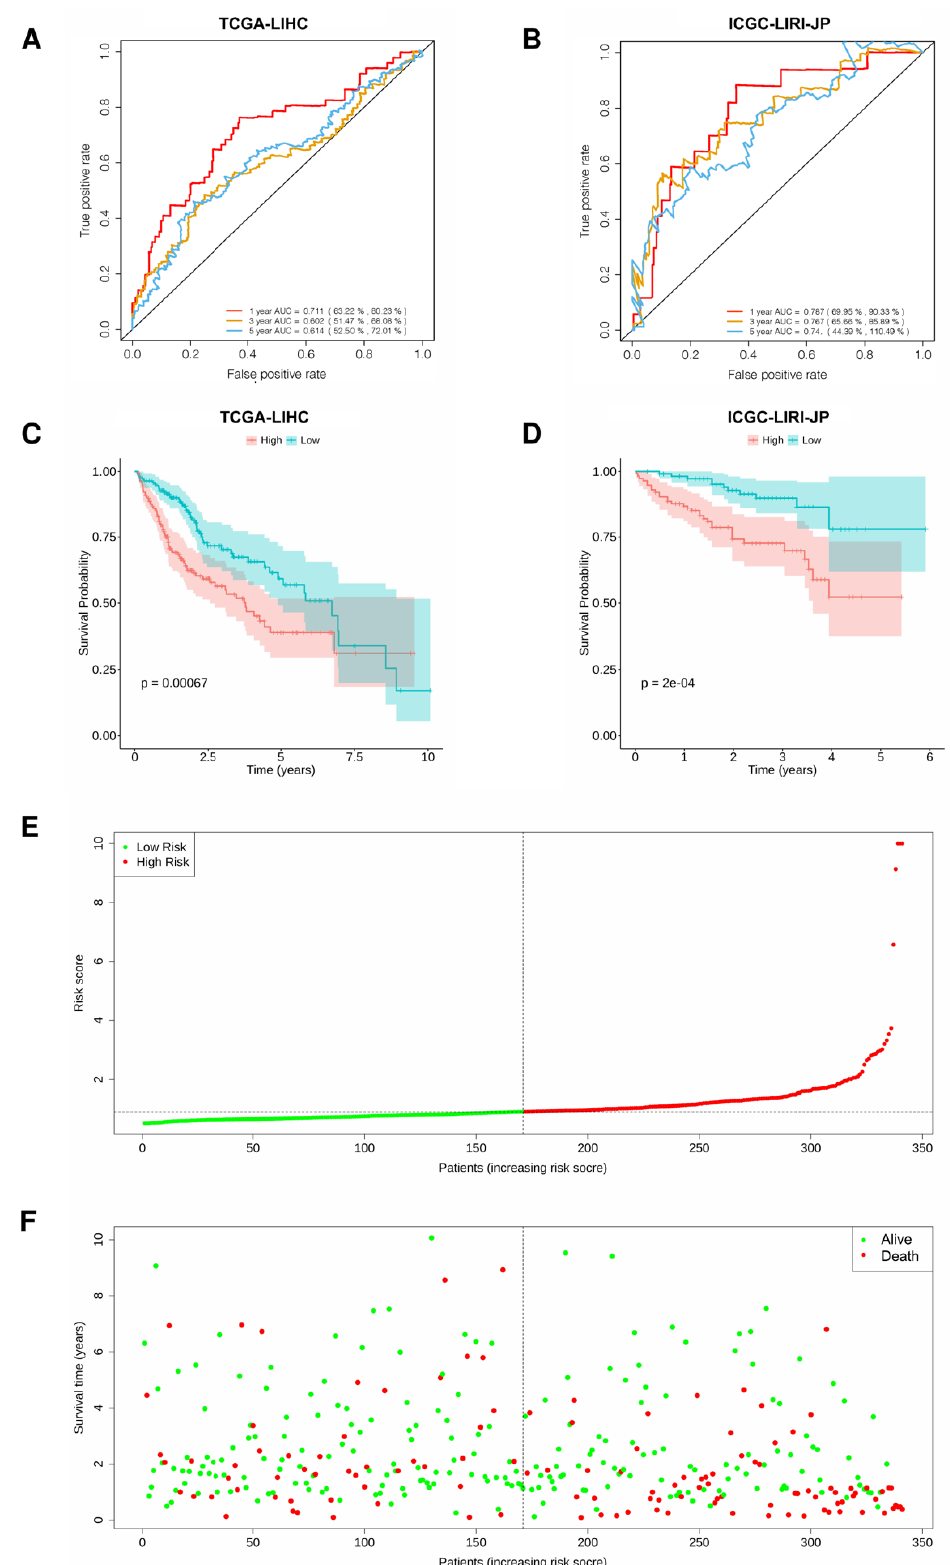
Figure 5. Validation of the three-gene signature in HCC. ( A , B ) Time-dependent ROC curves of the three-gene signature in two datasets. ( C , D ) Kaplan-Meier curves of risk subgroups in the two datasets. ( E , F ) The association between survival status and RS. Integration nomogram based on risk score and cancer status for HCC prediction.